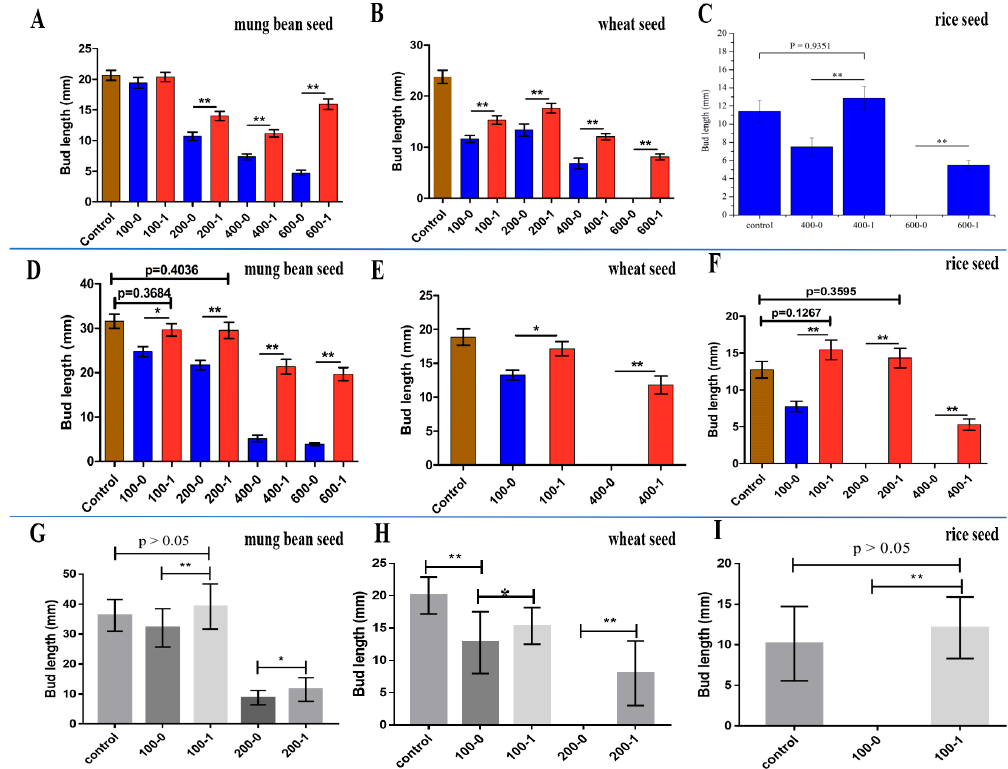
Figure 8. Phytotoxicities of individual chlorophenols (2,6-DCP, 2,3,6-TCP) and chlorophenol mix- tures (2,6-DCP + 2,3,6-TCP) at different concentrations before and after degradation by LAC-4. The plant seed shoots in chlorophenols treated with LAC-4 laccase and the plant seed shoots exposed to untreated chlorophenols were measured, respectively. *, significant difference ( p < 0.05); **, very significant difference ( p < 0.01). ( A ) The toxicity measurements for the 2,6-DCP degradation products by LAC-4 on mung bean seed germination. Control: no addition of 2,6-DCP; 100-0: 100 mg/L of 2,6-DCP not treated with LAC-4; 100-1: 100 mg/L of 2,6-DCP treated with LAC-4; 200-0: 200 mg/L of 2,6-DCP not treated with LAC-4; 200-1: 200 mg/L of 2,6-DCP treated with LAC-4; 400-0: 400 mg/L of 2,6-DCP not treated with LAC-4; 400-1: 400 mg/L of 2,6-DCP treated with LAC-4; 600-0: 600 mg/L of 2,6-DCP not treated with LAC-4; 600-1: 600 mg/L of 2,6-DCP treated with LAC-4. ( B ) The toxicity measurements for the 2,6-DCP degradation products by LAC-4 on wheat seed germination. Control: no addition of 2,6-DCP; 100-0: 100 mg/L of 2,6-DCP not treated with LAC-4; 100-1: 100 mg/L of 2,6-DCP treated with LAC-4; 200-0: 200 mg/L of 2,6-DCP not treated with LAC-4; 200-1: 200 mg/L of 2,6-DCP treated with LAC-4; 400-0: 400 mg/L of 2,6-DCP not treated with LAC-4; 400-1: 400 mg/L of 2,6-DCP treated with LAC-4; 600-0: 600 mg/L of 2,6-DCP not treated with LAC-4; 600-1: 600 mg/L of 2,6-DCP treated with LAC-4. ( C ) The toxicity measurements for the 2,6-DCP degradation prod- ucts by LAC-4 on rice seed germination. Control: no addition of 2,6-DCP; 400-0: 400 mg/L of 2,6- DCP not treated with LAC-4; 400-1: 400 mg/L of 2,6-DCP treated with LAC-4; 600-0: 600 mg/L of 2,6-DCP not treated with LAC-4; 600-1: 600 mg/L of 2,6-DCP treated with LAC-4. ( D ) The toxicity measurements for the 2,3,6-TCP degradation products by LAC-4 on mung bean seed germination. Control: no addition of 2,3,6-TCP; 100-0: 100 mg/L of 2,3,6-TCP not treated with LAC-4; 100-1: 100 mg/L of 2,3,6-TCP treated with LAC-4; 200-0: 200 mg/L of 2,3,6-TCP not treated with LAC-4; 200-1: 200 mg/L of 2,3,6-TCP treated with LAC-4; 400-0: 400 mg/L of 2,3,6-TCP not treated with LAC-4; 400-1: 400 mg/L of 2,3,6-TCP treated with LAC-4; 600-0: 600 mg/L of 2,3,6-TCP not treated with LAC- 4; 600-1: 600 mg/L of 2,3,6-TCP treated with LAC-4. ( E ) The toxicity measurements for the 2,3,6-TCP degradation products by LAC-4 on wheat seed germination. Control: no addition of 2,3,6-TCP; 100- 0: 100 mg/L of 2,3,6-TCP not treated with LAC-4; 100-1: 100 mg/L of 2,3,6-TCP treated with LAC-4; 400-0: 400 mg/L of 2,3,6-TCP not treated with LAC-4; 400-1: 400 mg/L of 2,3,6-TCP treated with LAC- 4. ( F ) The toxicity measurements for the 2,3,6-TCP degradation products by LAC-4 on rice seed ger- mination. Control: no addition of 2,3,6-TCP; 100-0: 100 mg/L of 2,3,6-TCP not treated with LAC-4; 100-1: 100 mg/L of 2,3,6-TCP treated with LAC-4; 200-0: 200 mg/L of 2,3,6-TCP not treated with LAC- 4; 200-1: 200 mg/L of 2,3,6-TCP treated with LAC-4; 400-0: 400 mg/L of 2,3,6-TCP not treated with